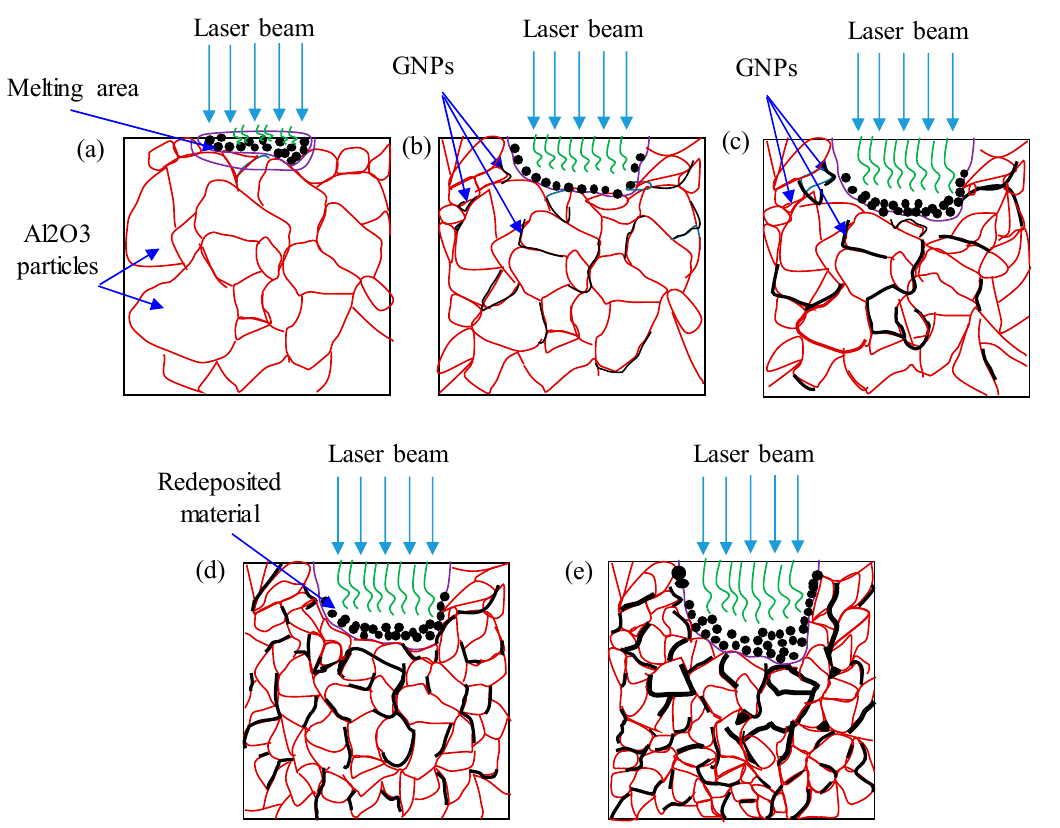
Figure 14. Schematic diagram of laser beam machining, ( a ) base Al 2 O 3 ; ( b ) 0.5 GNP/Al 2 O 3 nanocomposites; ( c ) 1 wt.% GNP/Al 2 O 3 nanocomposites; ( d ) 1.5 wt.% GNP/Al 2 O 3 ; ( e ) 2.5 wt.% GNP/Al 2 O 3 nanocomposites.